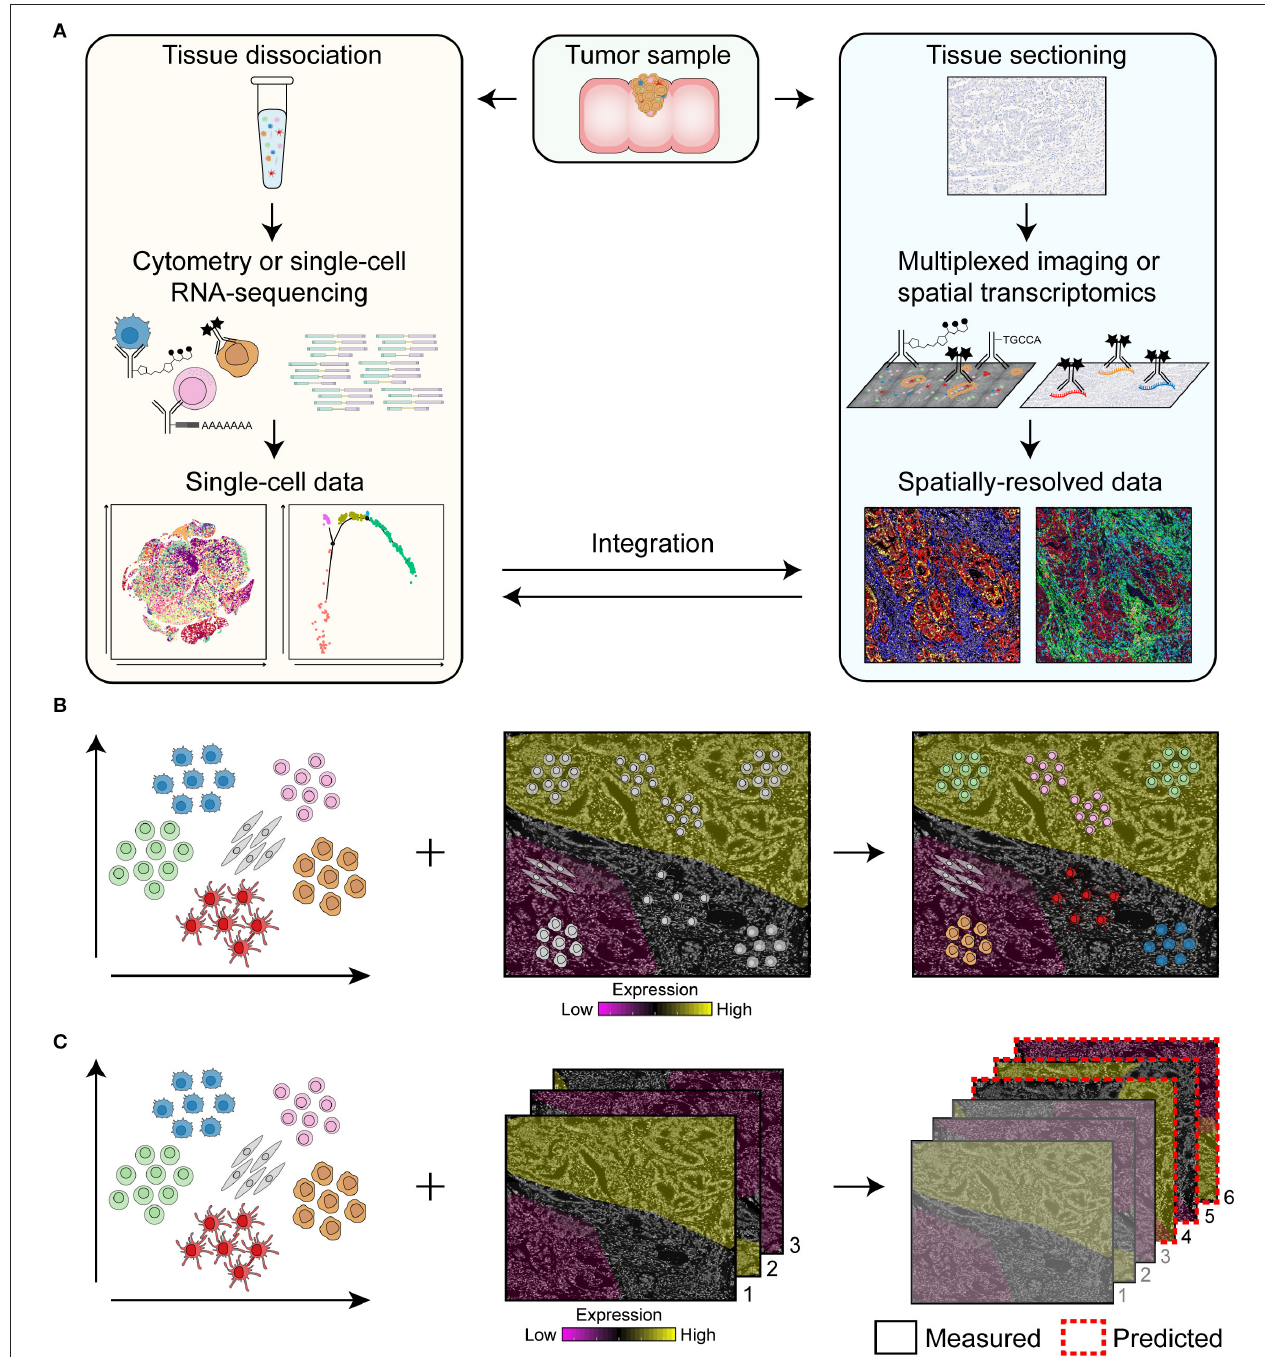
FIGURE 1 | Overview of the pipeline for the integration of single-cell data of dissociated cells and spatially-resolved data. (A) Single-cell data can be obtained by flow and mass cytometry that make use of antibodies coupled to fluorochromes or heavy metal isotopes, respectively, for the immunodetection of dissociated cells. For single-cell RNA-sequencing, antibodies coupled to oligonucleotides can be used to simultaneously retrieve information on protein and RNA expression of single cells. Spatially-resolved data can be obtained by multiplexed imaging or spatial transcriptomics by immunodetection of tissue sections with antibodies coupled to fluorochromes, heavy metal isotopes or oligonucleotides. Integration of single-cell data of dissociated cells with spatially-resolved data will reveal the full cellular landscape of the cancer microenvironment. (B,C) Integration approaches for single-cell data of dissociated cells and spatially-resolved data. Single-cell data of dissociated cells can be used as guide for cell type identification in spatial data and, vice versa, spatially-resolved data can be used to predict the location of dissociated cells based on the similarity of their expression profiles to spatially-mapped data (B) . In addition, single-cell data can be used to predict the spatial profile of genes or proteins in the samples that have not been measured to expand the coverage of spatial data (C) . Based on samples that have been measured (i.e., sample 1, 2, and 3), the expression of genes or proteins in sample 4, 5, and 6 can be predicted.